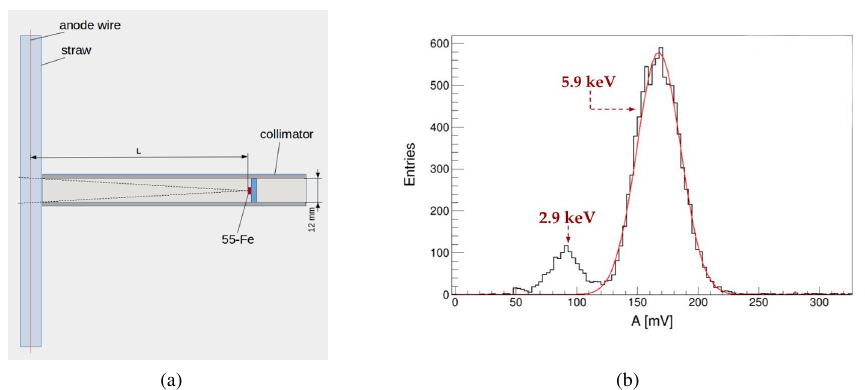
Figure 1: (a) Experimental setup. (b) Amplitude spectrum for 55 Fe source (black line) and a gaussian fitted to the 5.9 keV peak (red line).